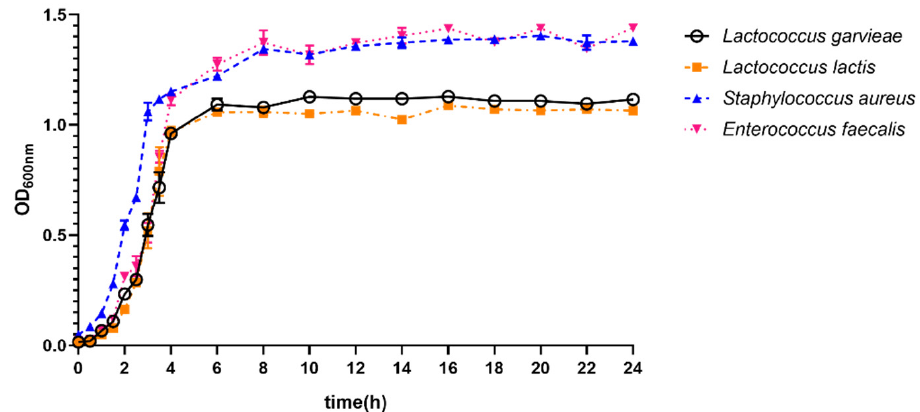
Figure 4. Growth curves of L. garvieae , L. lactis , S. aureus , and E. faecalis isolates. Data were mean ± SD of OD 600nm values of four isolates. The curves were plotted using GraphPad prism 8.